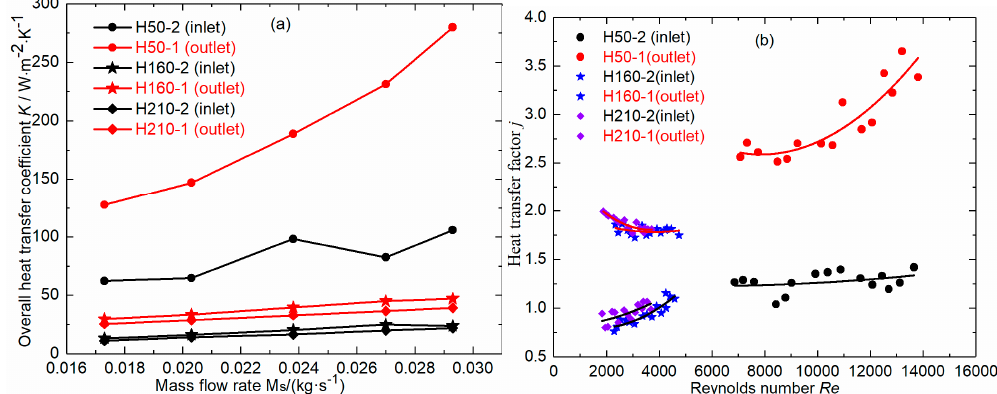
Figure 9. Heat transfer performance versus ( a ) mass flow rate and ( b ) reynolds number.